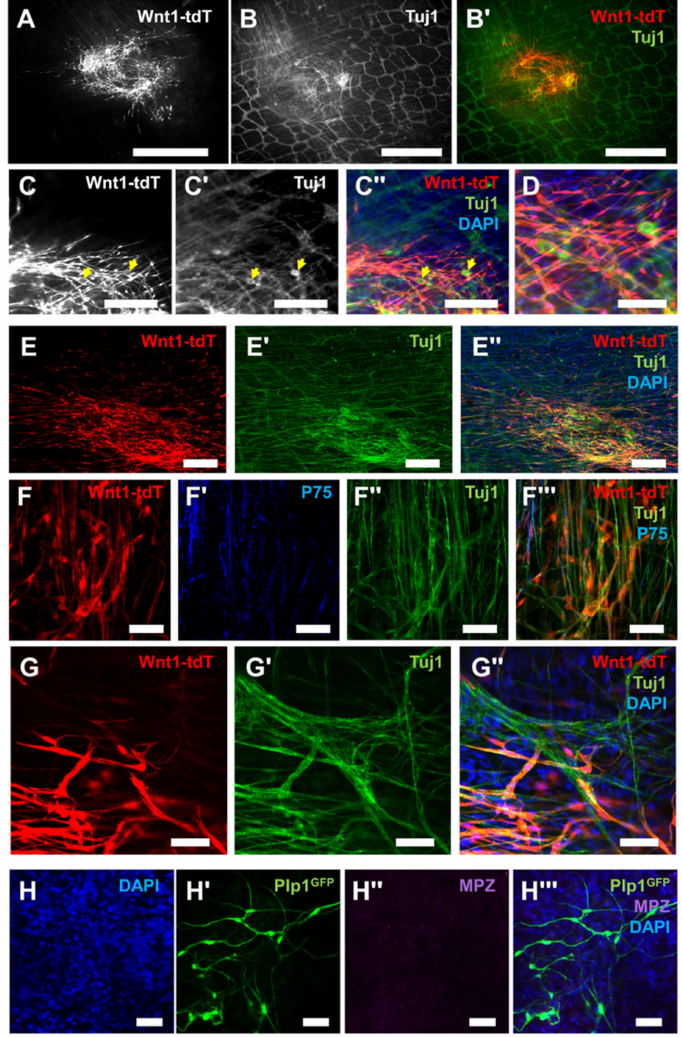
Figure 4. Bone marrow neural stem cells migrate, differentiate into neurons, and engraft with the enteric nervous system after in vivo transplantation. ( A ) Representative image of Wnt1-tdT + BM-NSC migration and cell spread in the mid-colon at 8 weeks post-implantation. Scale bar = 1 mm. ( B , B (cid:48) ) Images of whole-mount preparations of recipient longitudinal muscle myenteric plexus (LMMP) with Tuj1 ( B ) expression in transplanted Wnt1-tdT + NSCs ( B (cid:48) ). Scale bar = 1 mm. ( C – C (cid:48)(cid:48) ) Representative images of transplanted Wnt1-tdT + NSCs ( C ), Tuj1 expression ( C (cid:48) ), and merged image ( C (cid:48)(cid:48) ) in whole-mount preparations. Yellow arrows indicate Tuj1 + neuronal soma derived from BM- NSCs. Scale bar = 250 µ m. ( D ) High magnification image of the above. Scale bar = 100. ( E – E (cid:48)(cid:48) ) Representative images of the colorectum whole-mount preparations at 3 weeks post-transplantation containing Wnt1-tdT + BM-NSCs ( E ), Tuj1 expression ( E (cid:48) ), and merged image containing DAPI-stained nuclei ( E” ). Scale bar = 200 µ m. ( F – F (cid:48)(cid:48) ) Images of Wnt1-tdT + BM-NSCs ( F ) forming interconnected clusters of cells similar to ganglia, expressing P75 ( F (cid:48) ), Tuj1 ( F (cid:48)(cid:48) ), and merged image ( F (cid:48)(cid:48)(cid:48) ). Scale bar = 50 µ m. ( G – G” ) Images at the periphery of the implantation site showing Wnt1-tdT + BM-NSCs ( G ), expression of Tuj1 ( G (cid:48) ), and merged image including DAPI-stained nuclei ( G” ). Wnt1-tdT + BM-NSCs co-expressed Tuj1 and form connections with, and incorporate into, the host ENS. Scale bar = 50 µ m. ( H – H (cid:48)(cid:48)(cid:48) ) Representative images of DAPI-stained nuclei ( H ), transplanted Plp1 GFP+ BM-NSCs ( H (cid:48) ), MPZ expression ( H (cid:48)(cid:48) ), and merged image ( H (cid:48)(cid:48)(cid:48) ) depicting that BM-NSCs do not regain the expression of the myelinating Schwann cell protein MPZ after transplantation to the gut. Scale bar = 50 µ